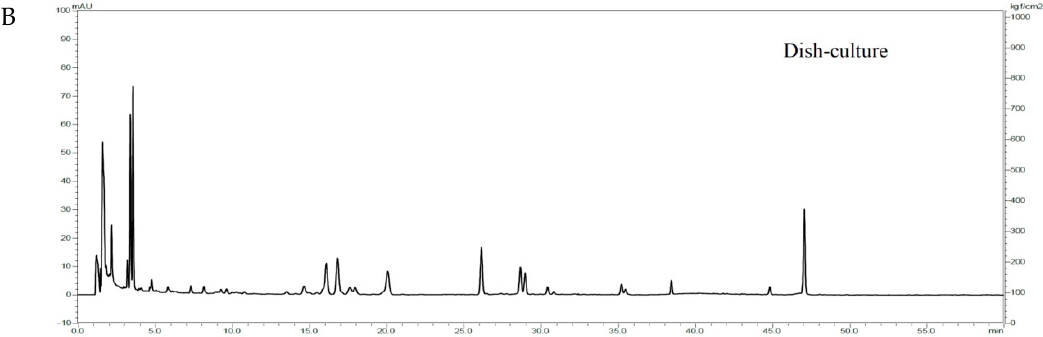
Figure 6. HPLC profiles of AC major triterpenoids of the ethanol extract of ( A ) wild fruiting bodies and ( B ) dish-cultured product (EEAC).